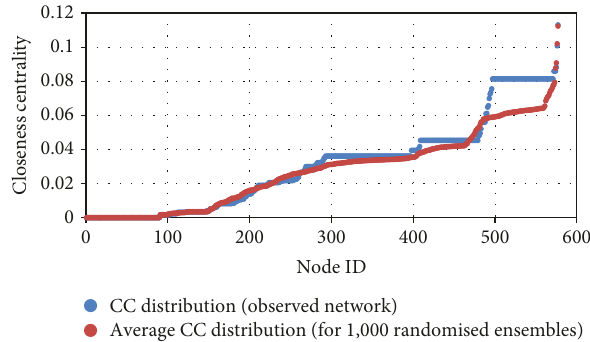
Figure 5: Closeness centrality distribution of the observed SCN (ref #: 18 — Computer Storage Devices) against the average closeness centrality distribution obtained from 1000 randomised